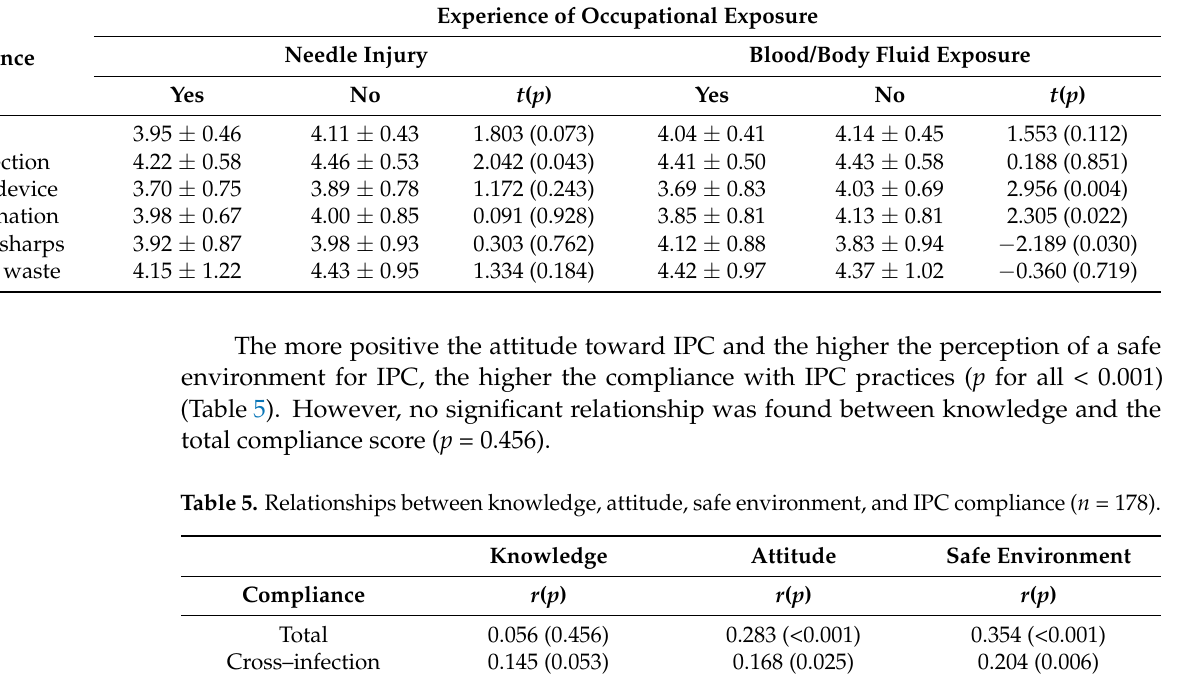
Table 4. Differences in infection prevention and control (IPC) compliance according to occupational exposure ( n = 178). Experience of Occupational Exposure Needle Injury Compliance